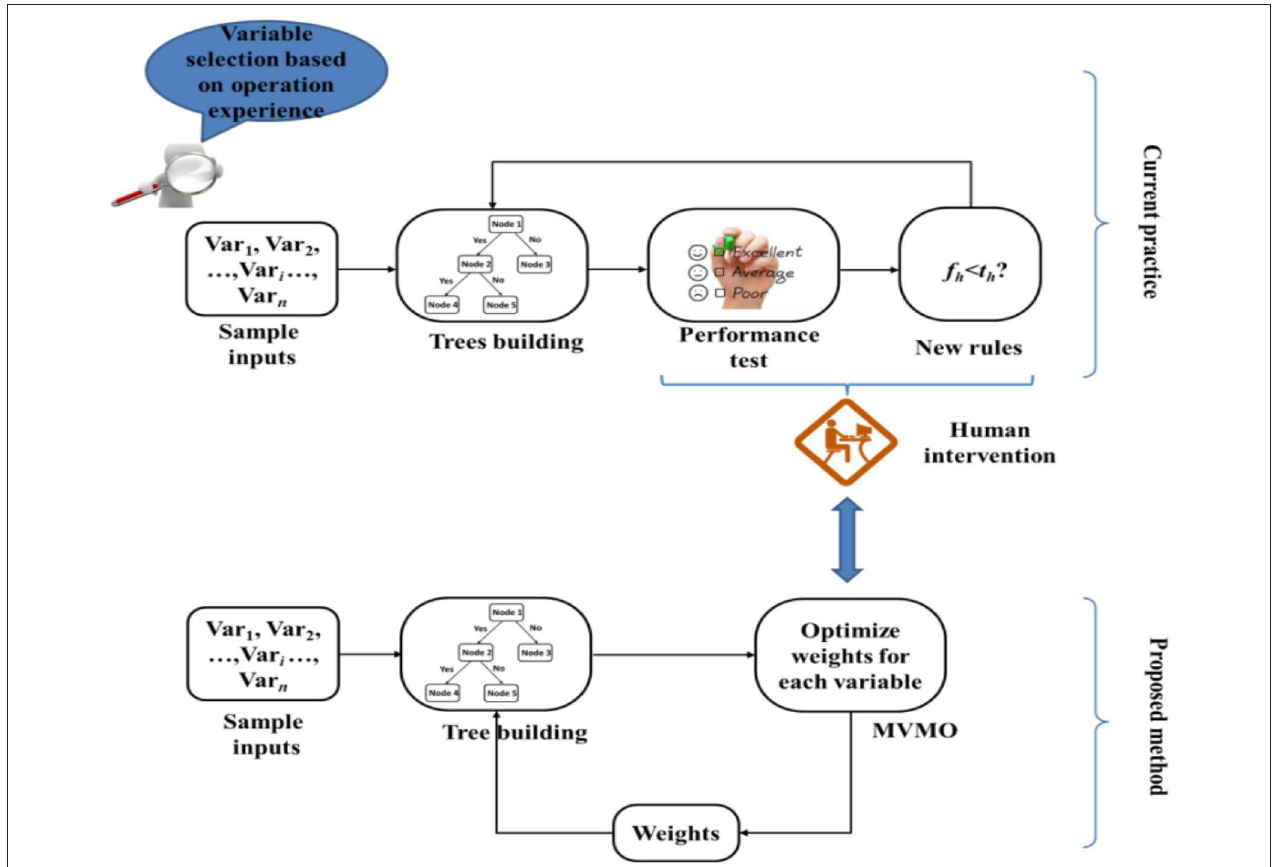
FIGURE 16 | Comparison between proposed method and current